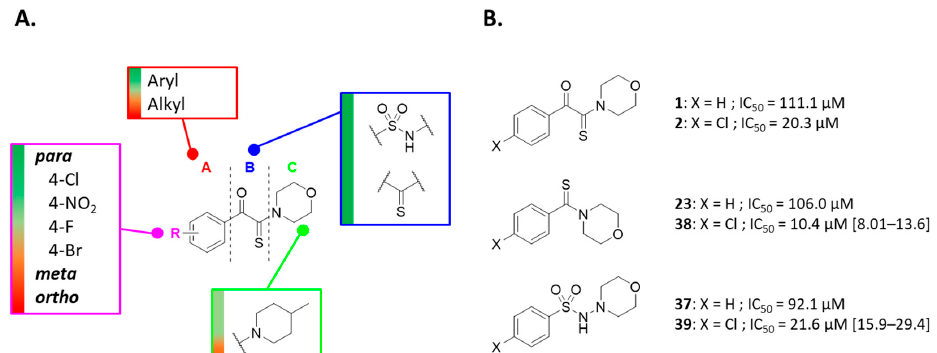
Figure 3. Overview of the structure − activity relationships. Color code: green > yellow > red, for decreasing PHGDH activity ( A ). Influence of the para ‐ chloro substitution on the potency of PHGDH inhibition ( B ). Under brackets: standard deviation in μ M.